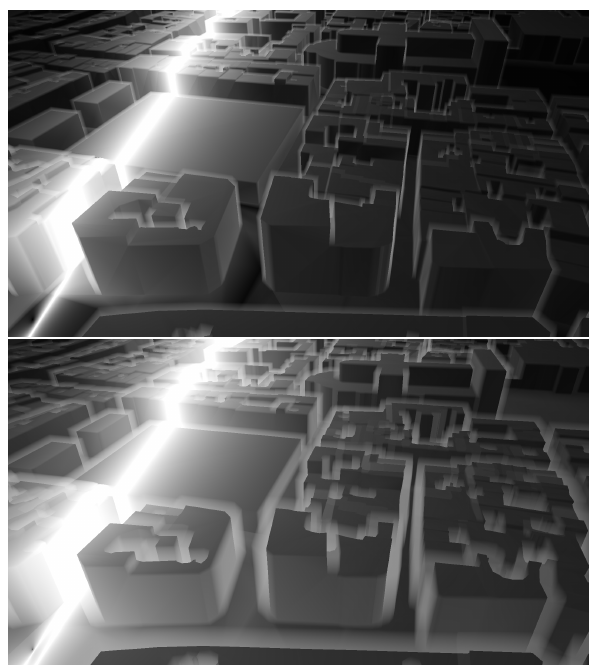
Figure 9: Aerial view of the uncertain model with differing struc- turing element sizes. Brightness corresponds to the length of in- tersection of the viewing ray with the uncertain scene, measured in pixels in projective texture space. Thus, this is exactly the con- tent of alpha channel before the final post-processing pass. The white stripe on the left corresponds to the projective image plane, where depth uncertainty has maximal effect. The black spot on the lower left corresponds to the direction of the projective image center, which is sharp no matter the scene